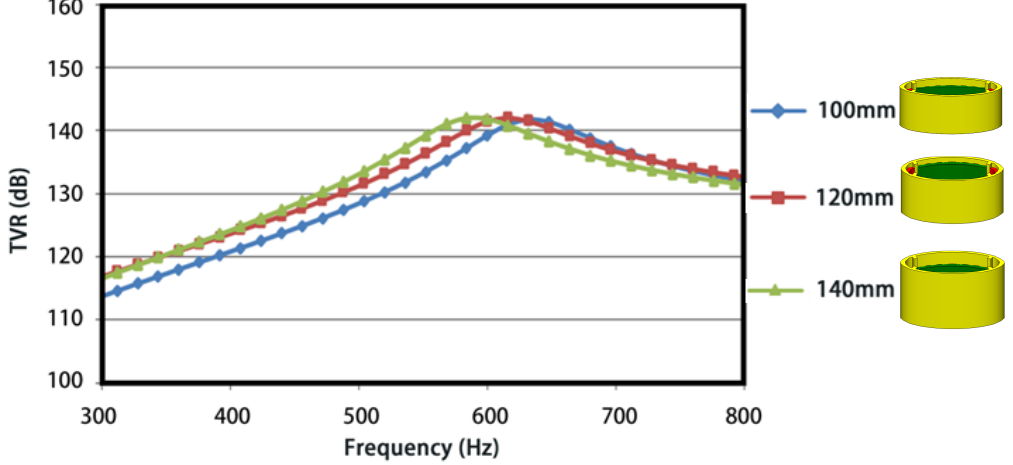
Figure 12. Influence of the Shell height on the TVR.